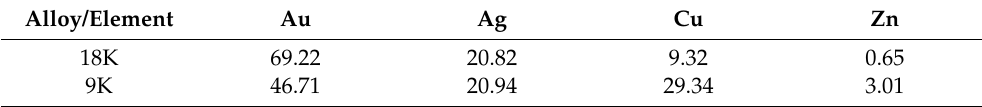
Table 3. Composition of gold alloys studied (wt.%) by XPS.